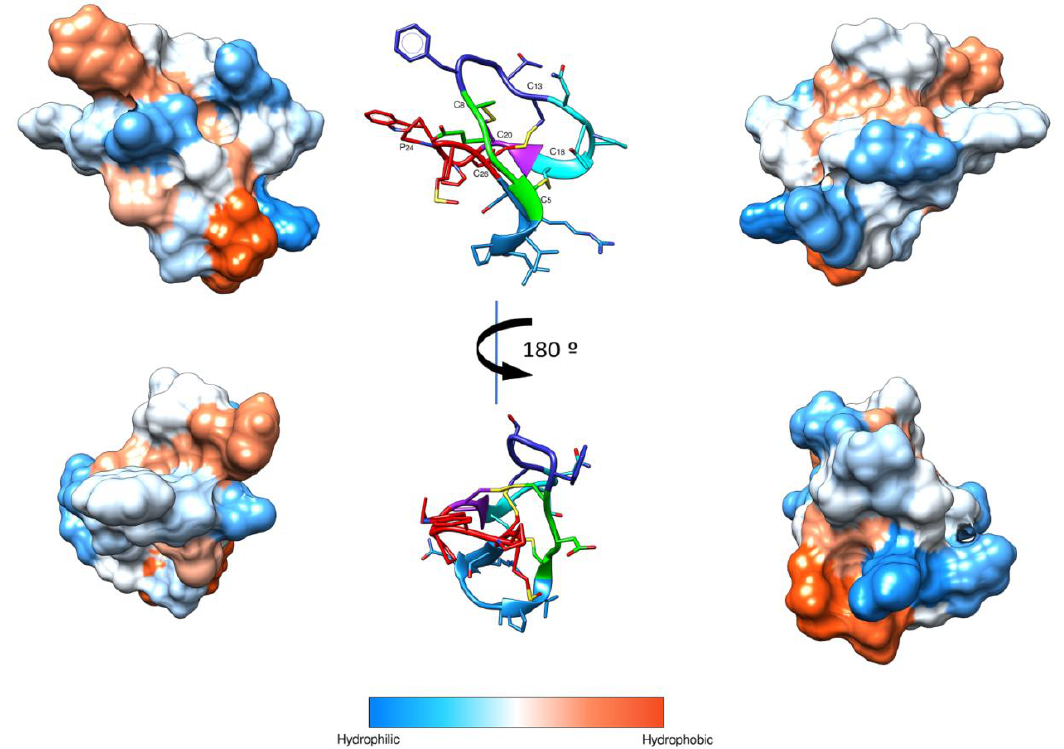
Figure 3. Schematic representation of VarvA structure. 3D structural model of the VarvA cyclotide in a ribbon representation is shown in the center, and disulfide bonds and P24 are indicated. The loops are colored: Loop 1 (green), Loop 2 (dark blue), Loop 3 (cyan), Loop 4 (purple), Loop 5 (red), and Loop 6 (light blue). The hydrophobic surface of the peptide was generated with a 1.4 Å probe and Kyte & Doolittle scale in UCSF Chimera [37]. Four different views of the surface are shown to facilitate visualization of the surface.